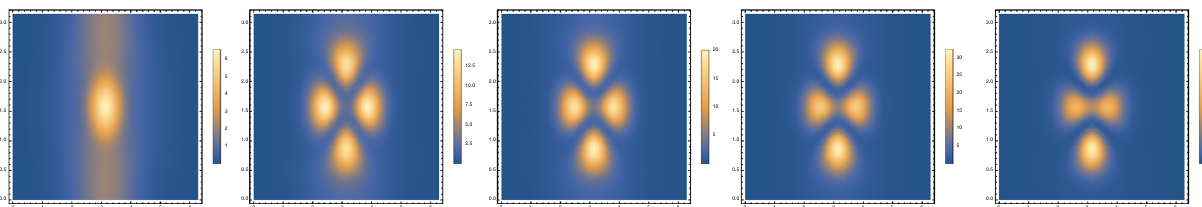
Fig. 3 Energy density for different configurations with B = 1. From left to right: energy density only including the non-linear sigma model contribution, then up to the Skyrme contribution, up to L 6 , up to L 8 and finally up to order L 12